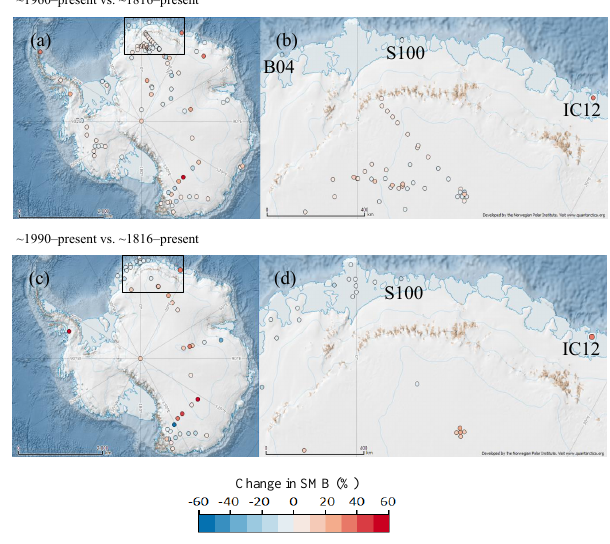
Figure 1. Location of IC12 and other ice cores referred to herein. (a–b) Difference in mean annual SMB between the period ∼ 1960– present and the period ∼ 1816–present (see Table S1 for exact pe- riods and references); (c–d) same as (a–b) for the period ∼ 1990– present compared with ∼ 1816–present. Panels (b) and (d) are ex- pansions of the framed areas in panels (a) and (c)